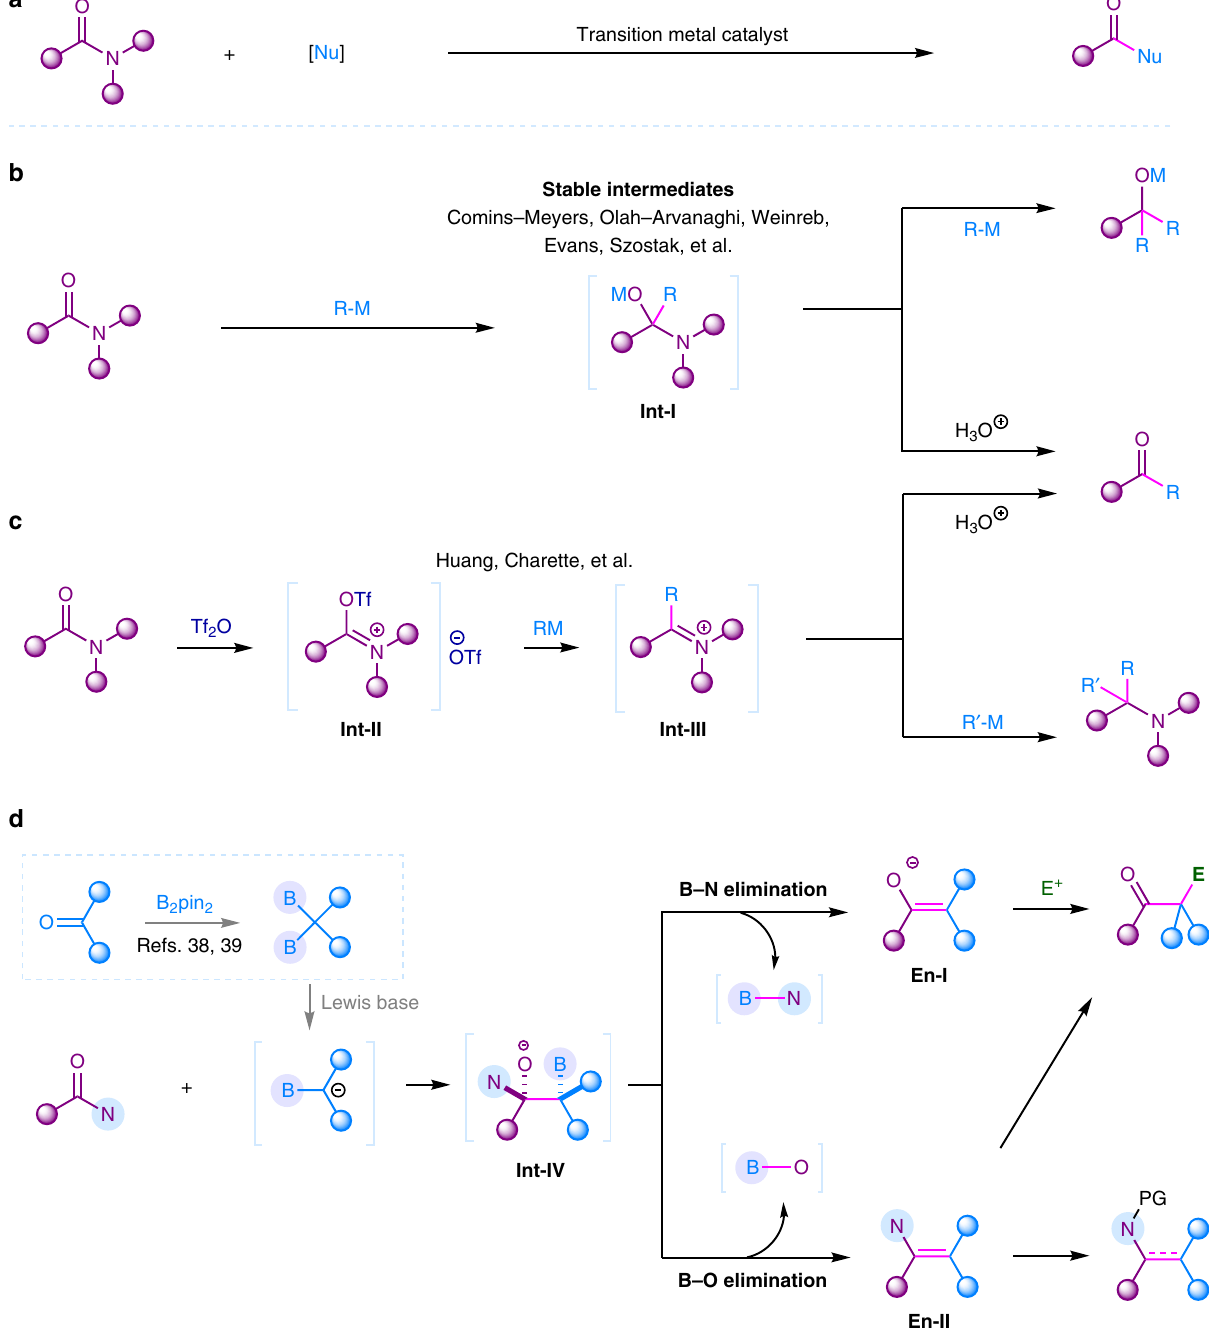
Fig. 1 Strategies for the direct transformations of simple amides. a Transition metal catalyzed C – N activation/functionalization of amides. b Direct addition of [R – M] reagents to tertiary amides. c Transformation of amides via electrophilic activation using Tf 2 O. d This work: chemodivergent transformations of amides using 1,1-diborylalkanes as